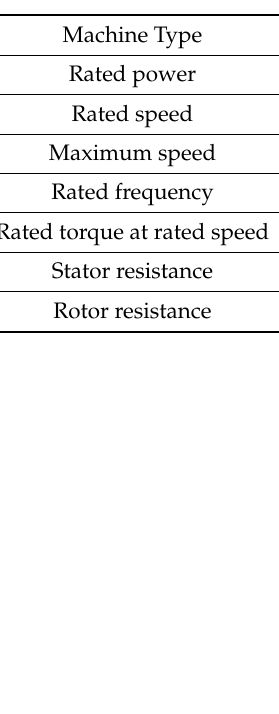
Table 1. Specification of the simulated and experimental induction